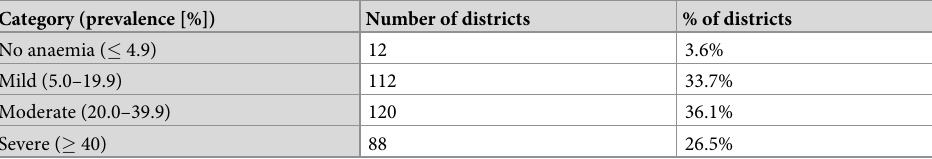
Table 5. District-level distribution of anaemia in Yemen,